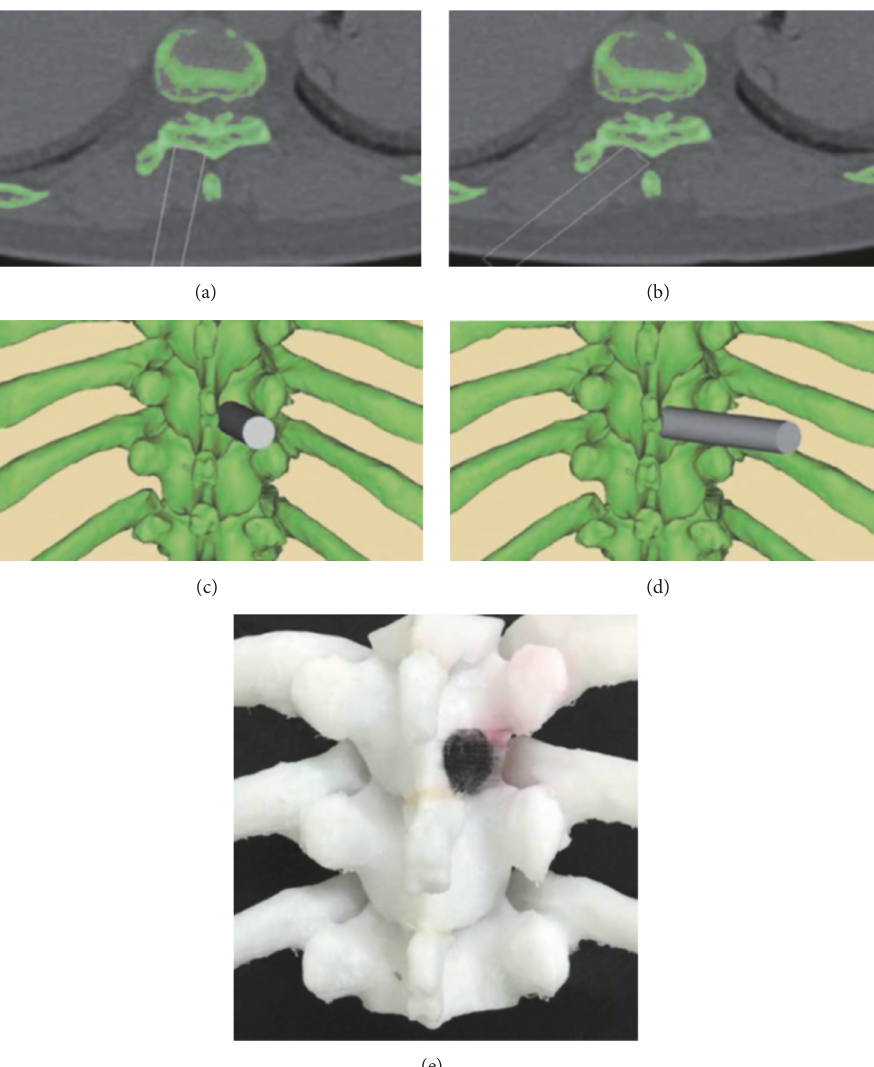
Figure 3: Surgical simulation demonstrating virtual channel placement (a–d). 3DP thoracic vertebra for preoperative planning (e) (source: reproduced and adapted with permission from Zhao et